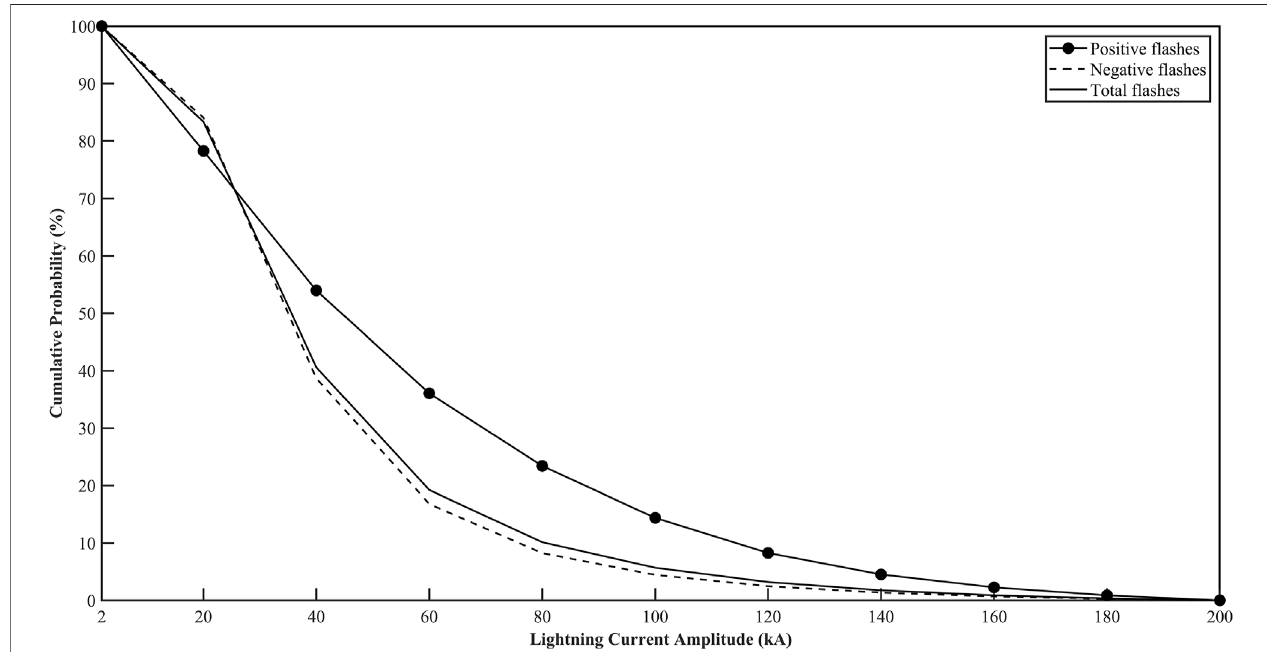
FIGURE 3 | Cumulative probability distribution curves of lightning current amplitude.